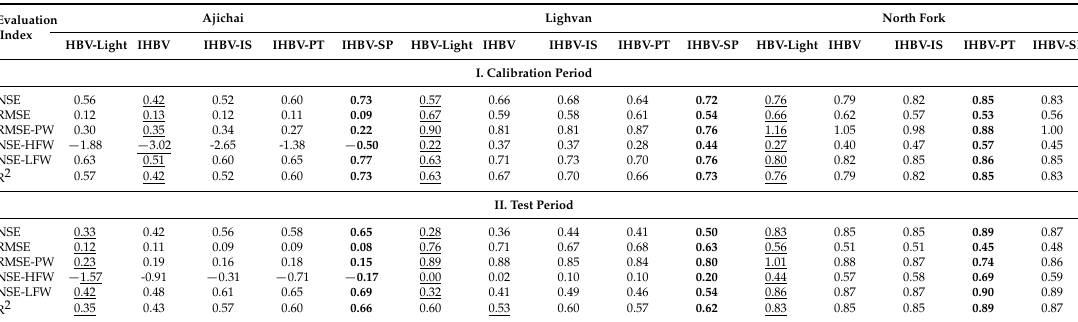
Table 5. Comparison of results for all the